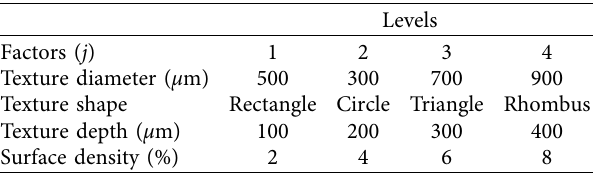
Figure 8: 700 micron diameter and 300 micron depth texture fluid pressure diagram and streamline diagram. Table 1: Levels of factors in texture